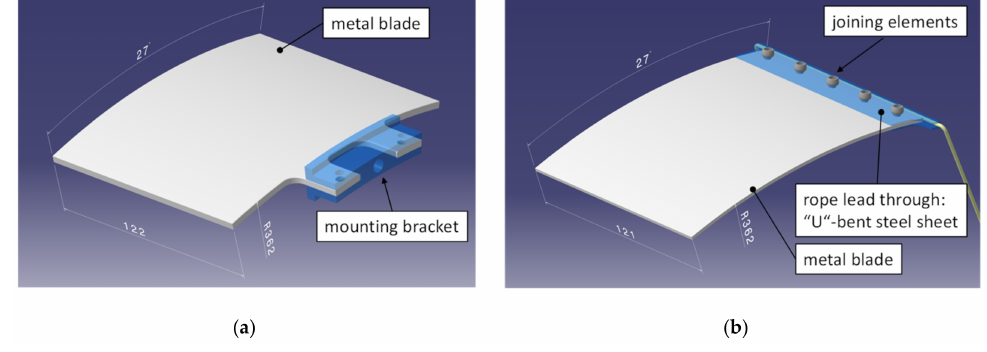
Figure 10. Metal blade design concepts: ( a ) tie rods mechanism; ( b ) rope